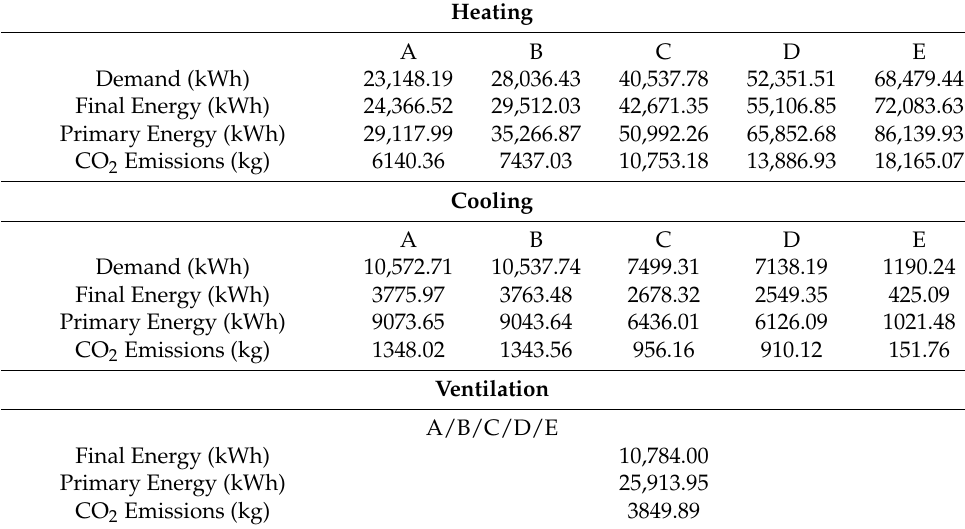
Table 8. Results Obtained with Schedule Control.